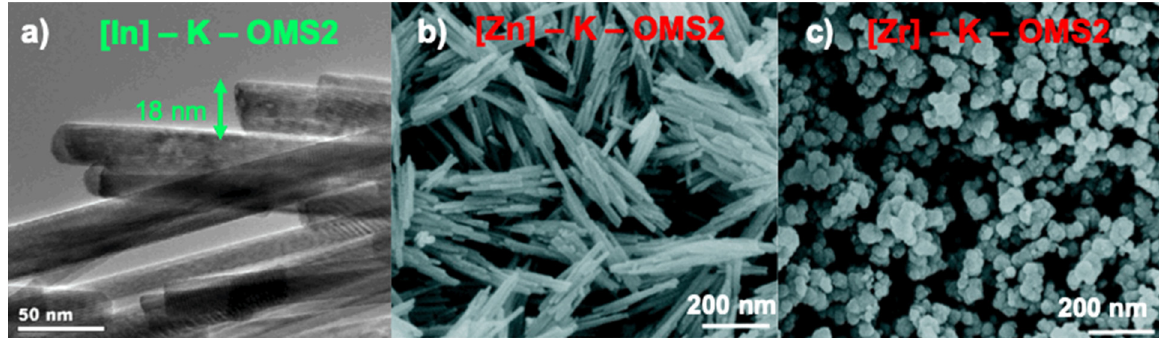
Figure 15. TEM image of [In]–K–OMS–2 (In/Mn = 1/5) ( a ), and FESEM images for [Zn]–K–OMS–2 (0.49% mol Zn) ( b ) and [Zr]–K–OMS–2 (7.50% mol Zr) ( c ). Images have been extracted and later adapted from references [188,189].